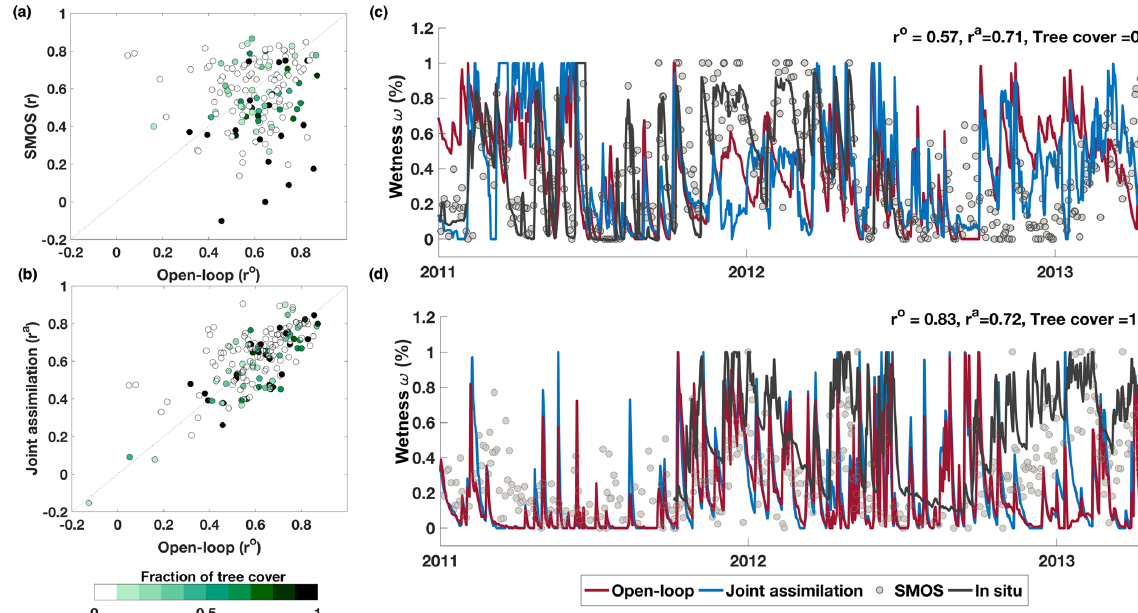
Figure 3. Assessment of near-surface soil moisture estimation with ISMN in situ measurements from 2010 to 2015: (a) correlations of SMOS soil moisture retrievals with in situ measurements ( y axis) compared against open-loop ( x axis); (b) correlation of near soil moisture estimates after the joint assimilation with in situ measurements ( y axis) compared against model open-loop ( x axis). Each ISMN site is characterized by the fraction of tree cover within the corresponding 0.25 ◦ cell. (c, d) Time series of simulated surface soil moisture before and after the joint assimilation over grassland and forest-dominated regions.